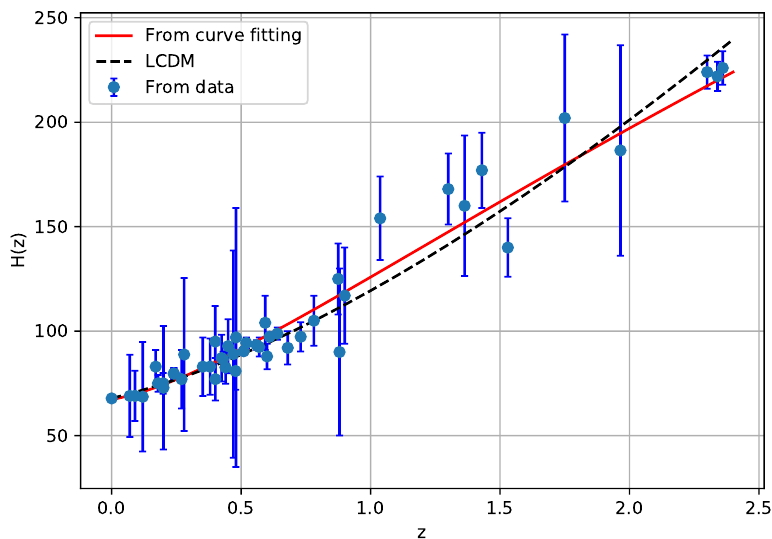
Figure 2. The evolution of Hubble parameter, H ( z ) , with respect to redshift z . The red line represents our model and dashed line indicates the Λ CDM model with the pressureless matter parameter, Ω = 0.3 [44] and the dark energy density parameter, Ω Λ m0 dataset with error bars